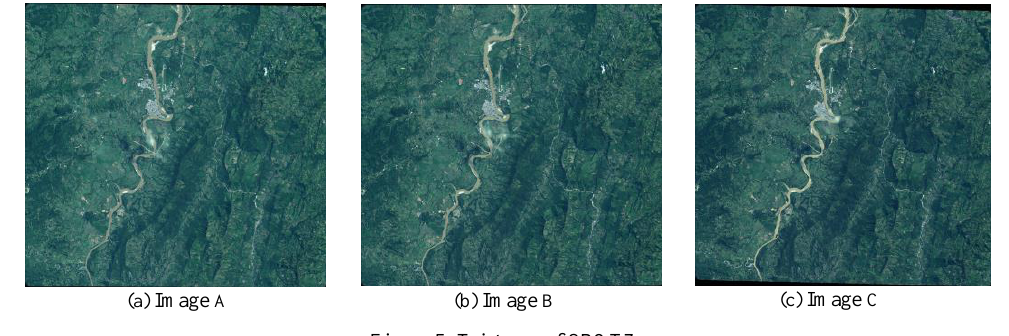
Figure 5. Tristereo of SPOT7